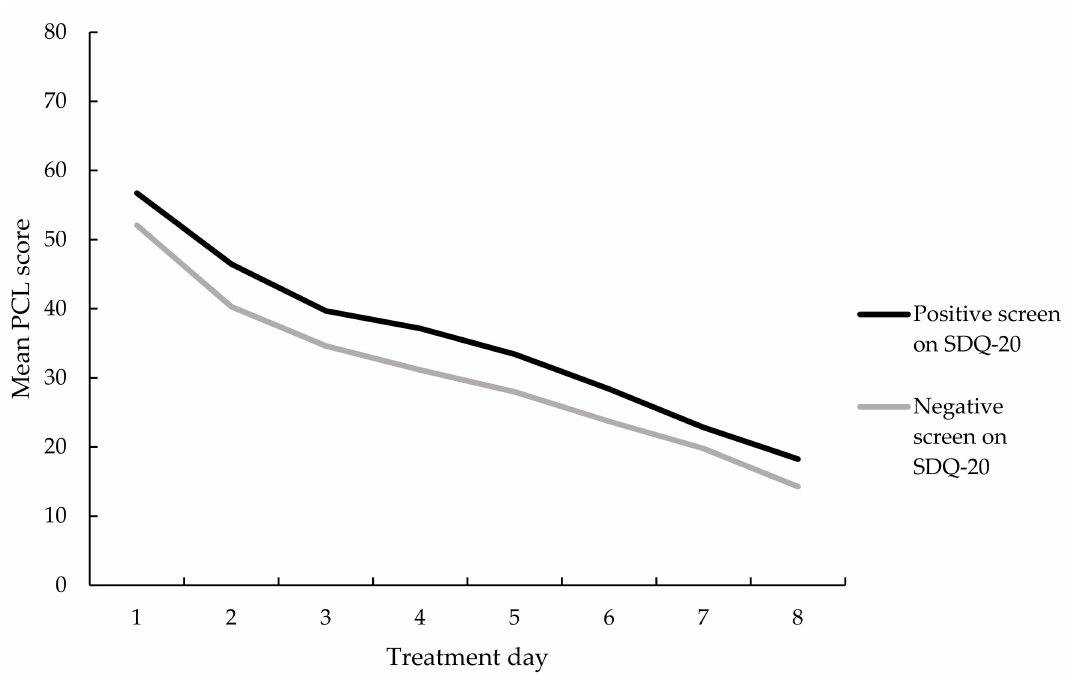
Figure 3. Mean PTSD Checklist for DSM-5 (PCL-5 scores) per treatment day for those with and without a positive screen on the SDQ-20, n =